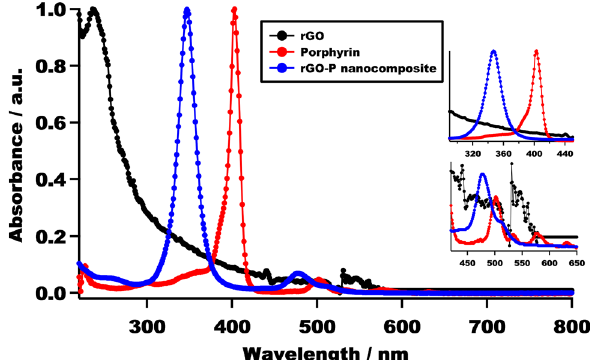
Figure 3. UV–Visible spectrum (measured in CHCl 3 ) of raw rGO, porphyrin, and rGO-P nanocomposite. The inset shows the blue shift of the Soret peak as well as Q-bands after the nanocomposite formation.